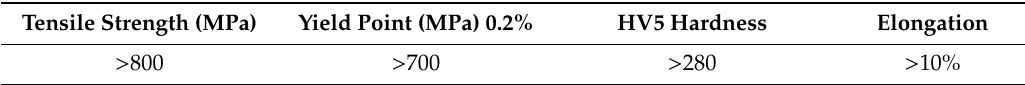
Table 2. Mechanical properties of Ti G4.